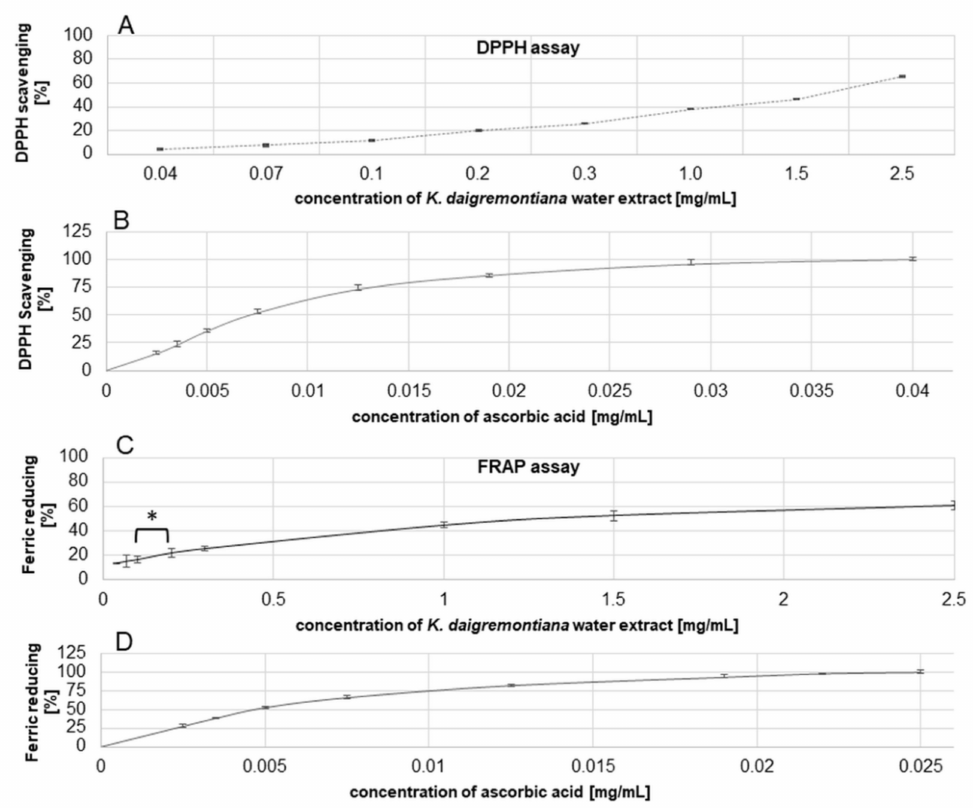
Figure 9. Antioxidant efficiency of K. daigremontiana water extract or ascorbic acid estimated in DPPH ( A , B ) and FRAP ( C , D ) tests. The results were obtained via spectrophotometry from three independent analyses in three replicates ( n = 9). Error bars indicate standard deviations. The statistical differences among the results were observed only in the FRAP test and are marked with an asterisk “*” (ANOVA with post hoc Tukey’s test, p <